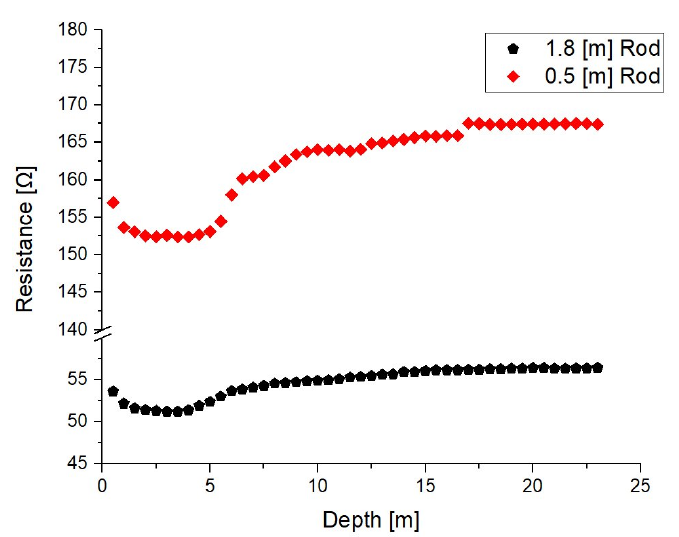
Figure 4. Variation of resistance by depth.